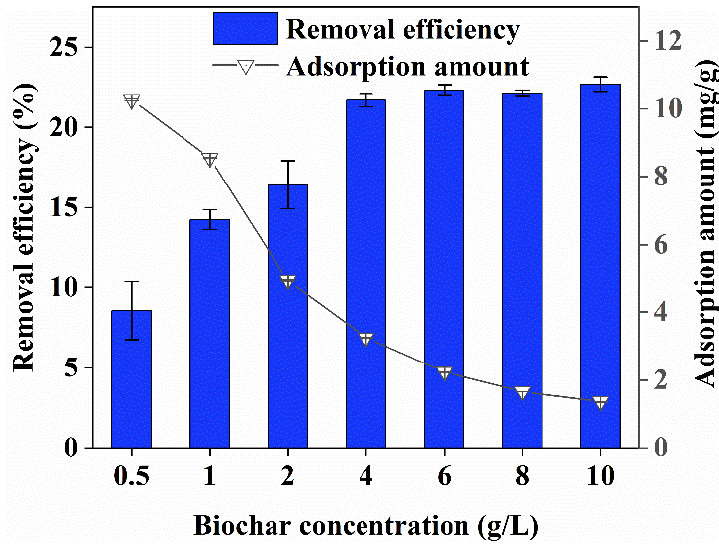
Figure 2. Effect of biochar concentration on Cr(VI) removal.